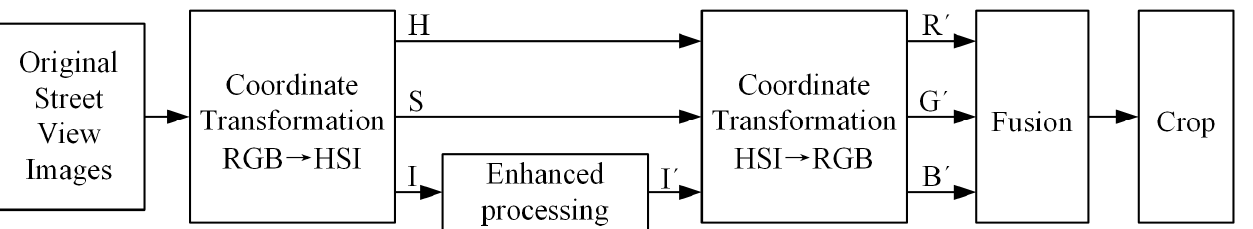
Figure 2. The preprocessing of street view images.